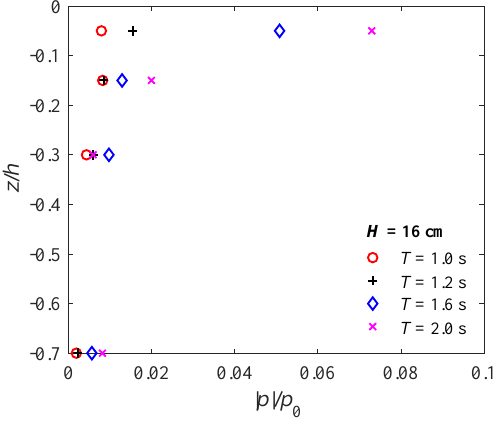
Figure 12. Distribution of the maximum pore-water pressures vs soil depth ( z / h ) behind the pile for various wave periods ( x = − 0.15 m, H = 16 cm, Points 17, 18, 19, and 7).